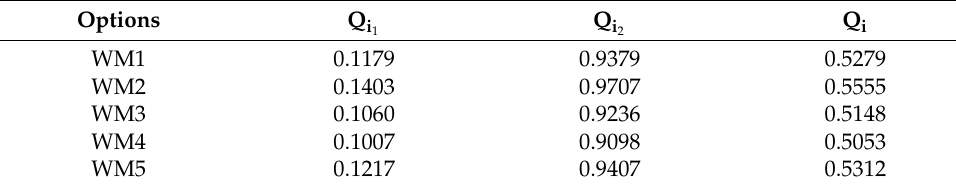
Table 7. Final value from the Weighted Aggregated Sum Product